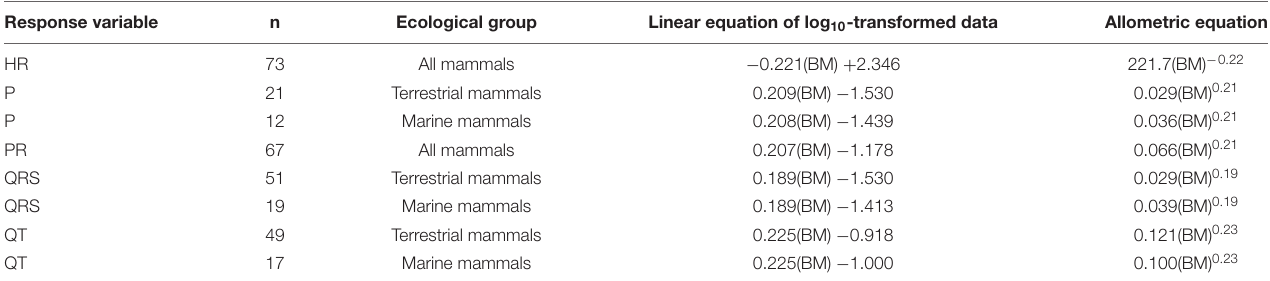
TABLE 2 | Linear regressions and allometric equations describing the relationship between body mass (BM) and ECG parameters for mammals separated by ecological group as appropriate. Response